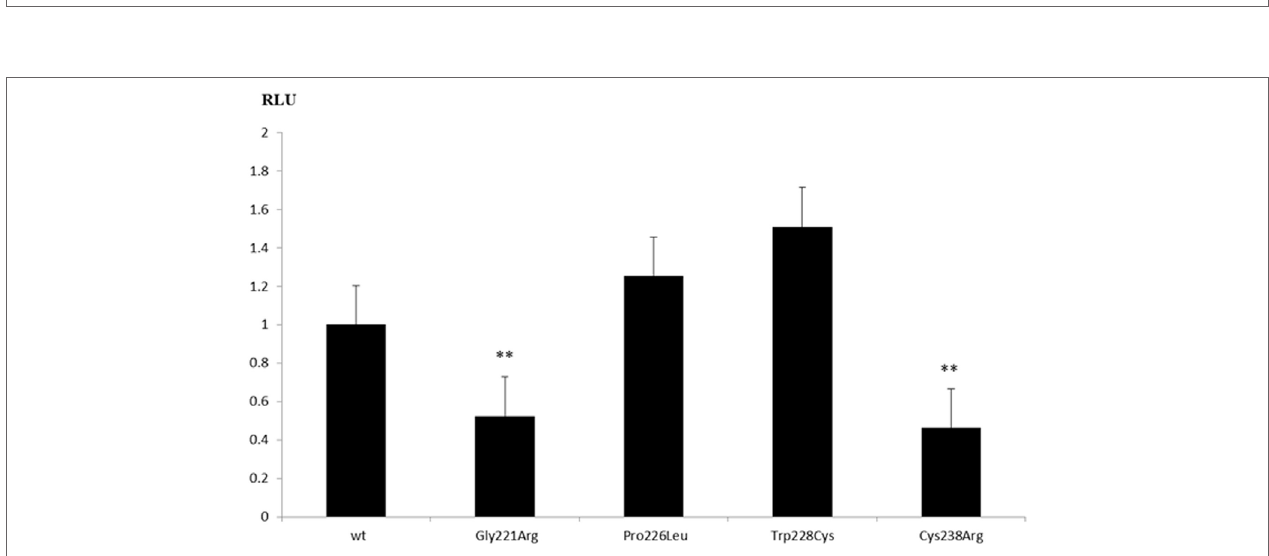
FigUre 2 | Multiple alignment of parts of the GATA4 protein sequences across species. Localization of the newly identified human aa variants are given in red and seem highly conserved across species. The localization of the so far only GATA4 mutation reported to cause a 46,XY DSD phenotype (p.Gly221Arg) is given in bold and its localization is also highly